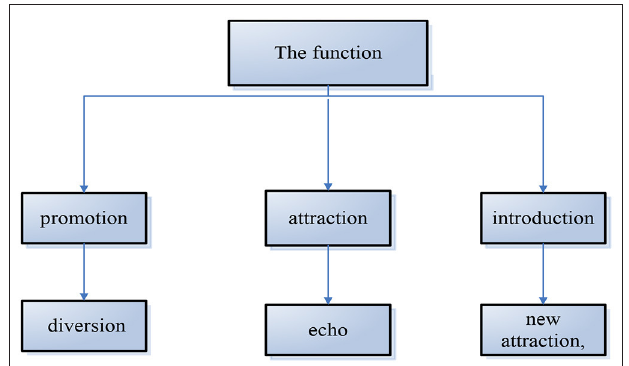
FIGURE 4 | The function of virtual tourism products.